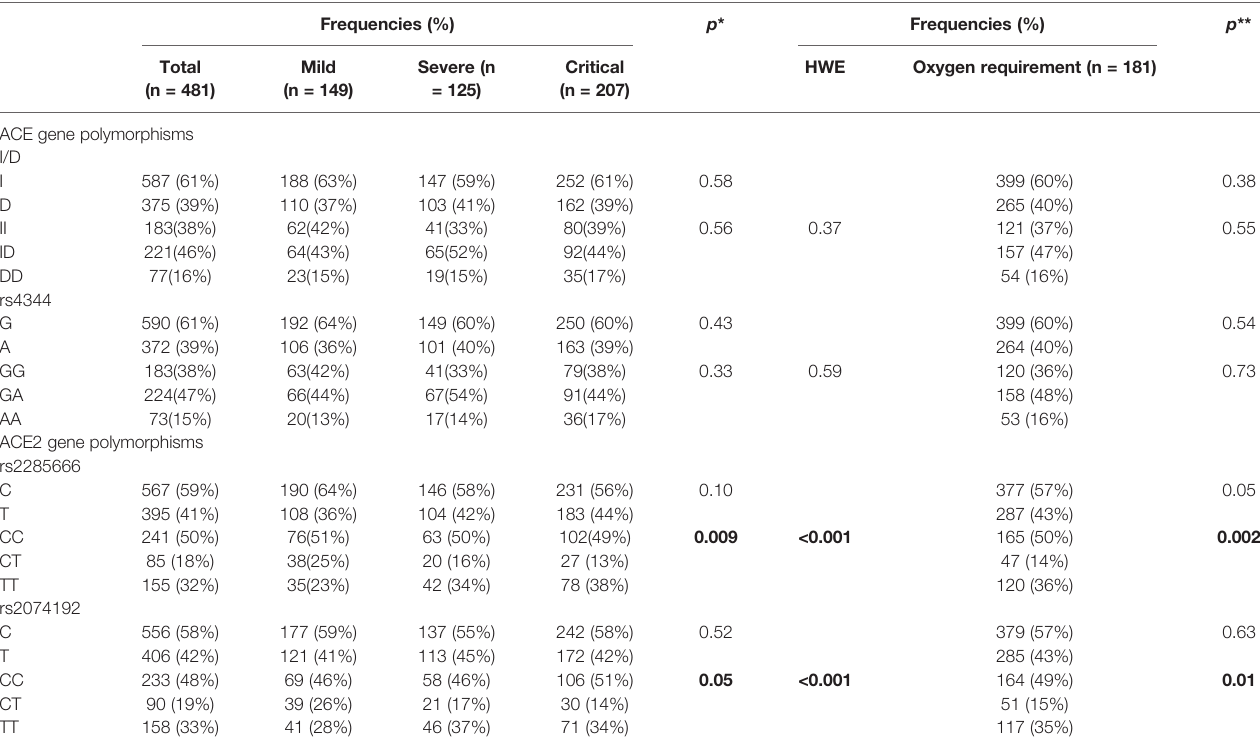
TABLE 2 | Allelic and genotypes frequencies of the population of